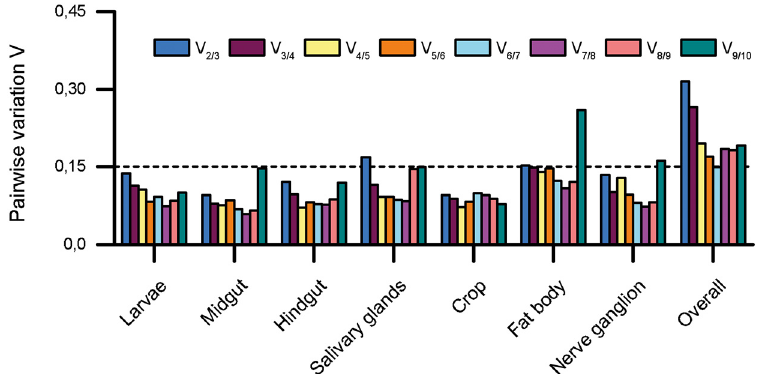
Fig 3. Determination of the optimal number of control genes for normalization. Pairwise variation (V n/n +1 ) analysis between the normalization factors NF n and NF n+1 to determine the number of reference genes required for accurate normalization in every individual sample group. The dashed line at 0.15 represents the set threshold below which the number of reference genes is optimal.